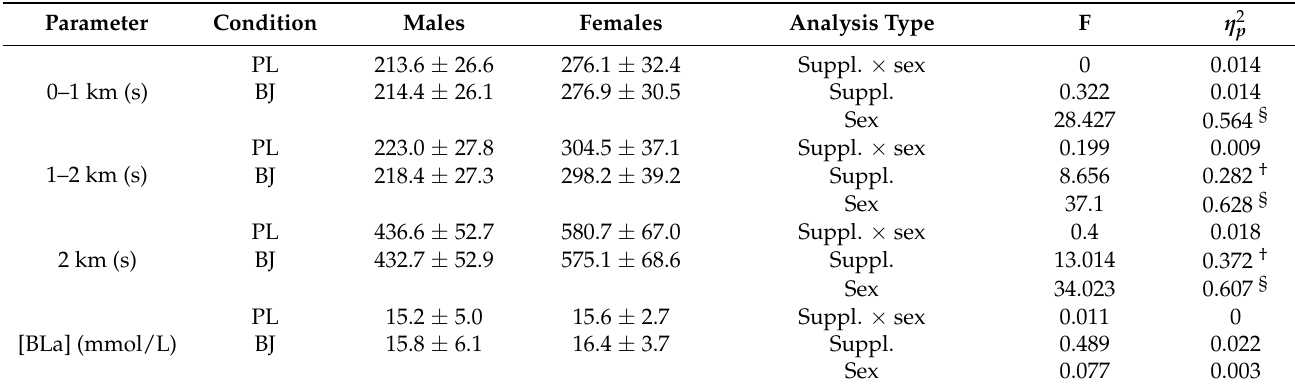
Table 2. Effect of nitrate-rich and nitrate-depleted beetroot juice supplementation on 2 km running performance and post-exercise blood lactate concentration.